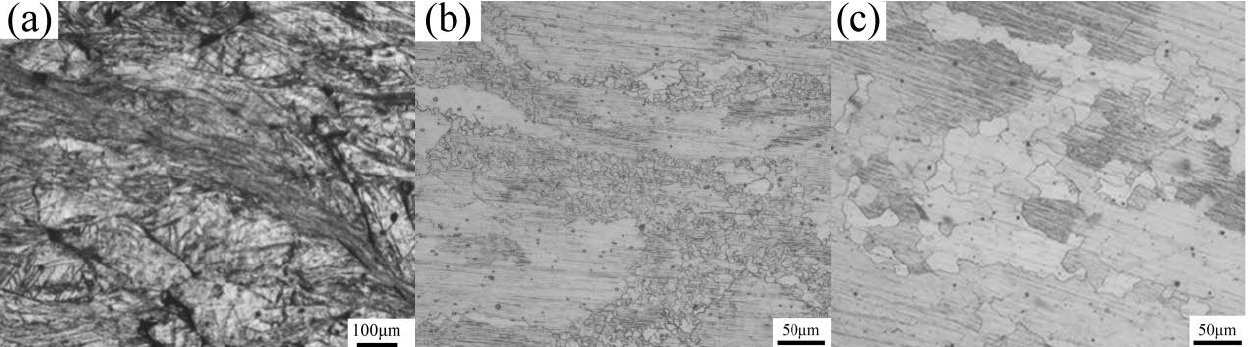
Figure 10. Microstructures at the strain rate of 0.01 s − 1 , the deformation rate of 60% and various temperatures of ( a ) 200 °C, ( b ) 300 °C and ( c ) 400 °C.